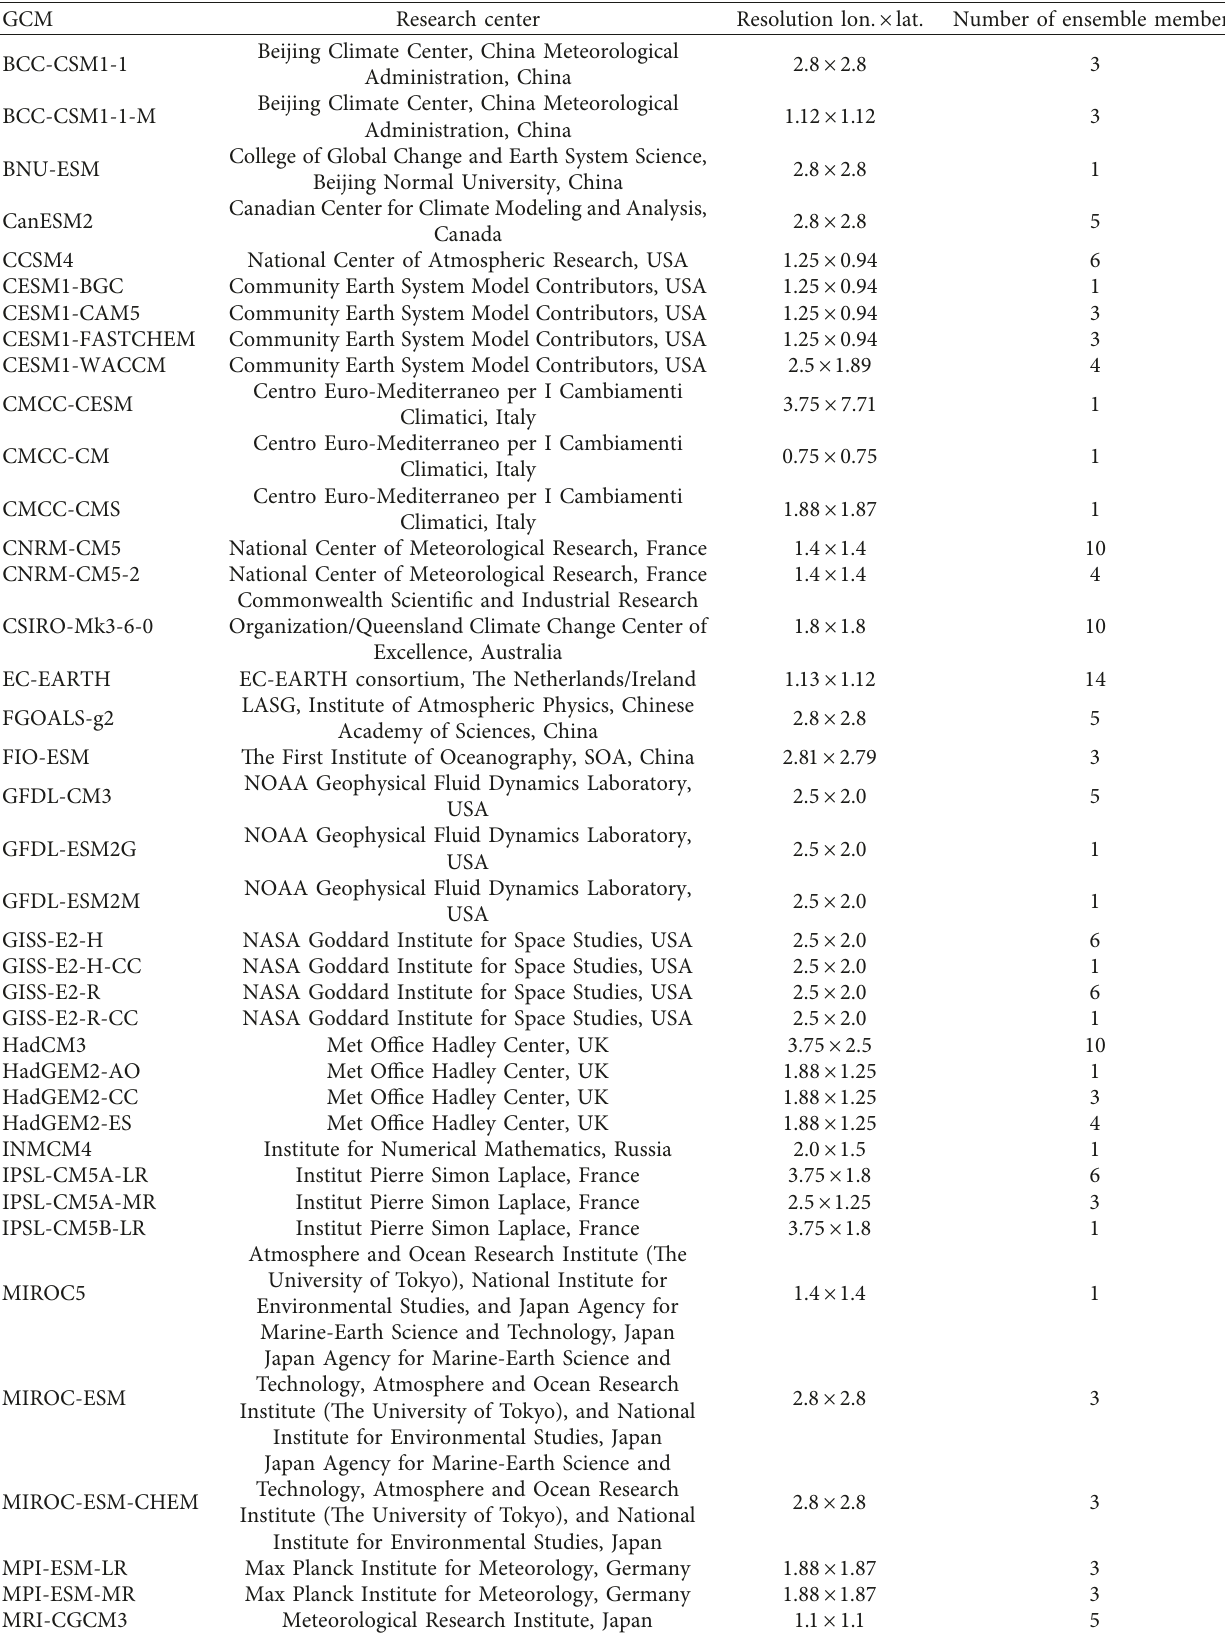
Table 1: Global climate models employed in this study together with their resolutions and numbers of ensemble members.